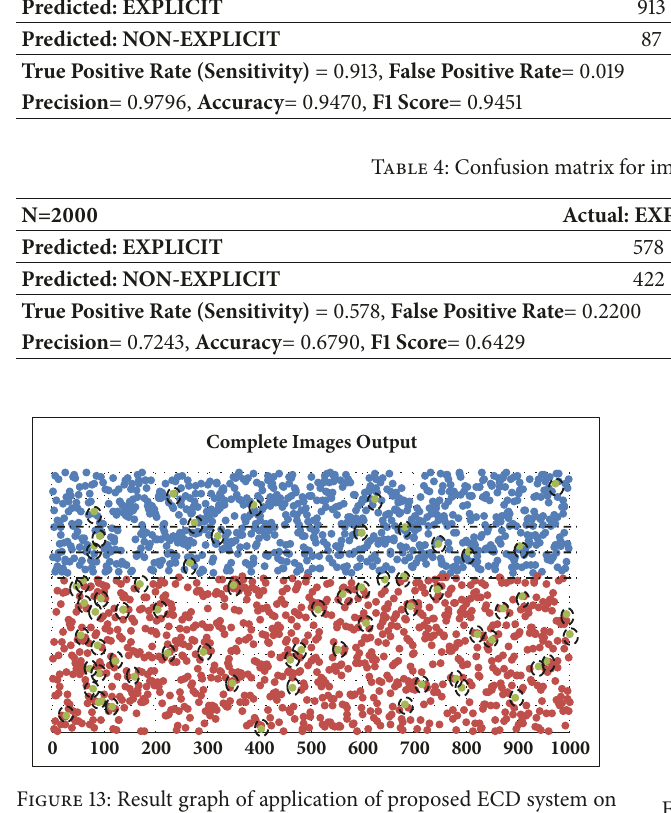
Figure 14: Result graph of application of the proposed ECD system on 500-explicit video